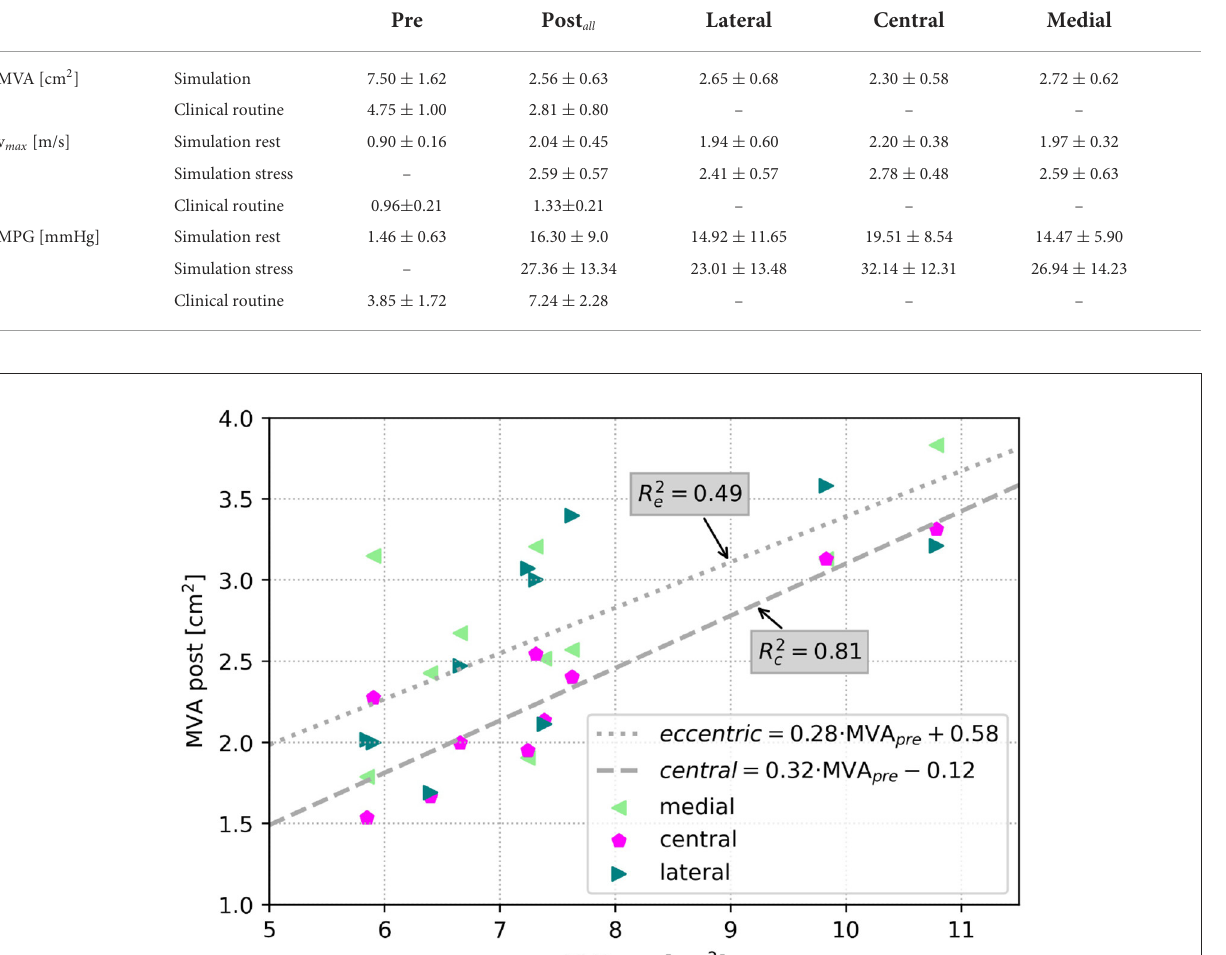
scattering with R 2 c = 0.81. For an illustration of